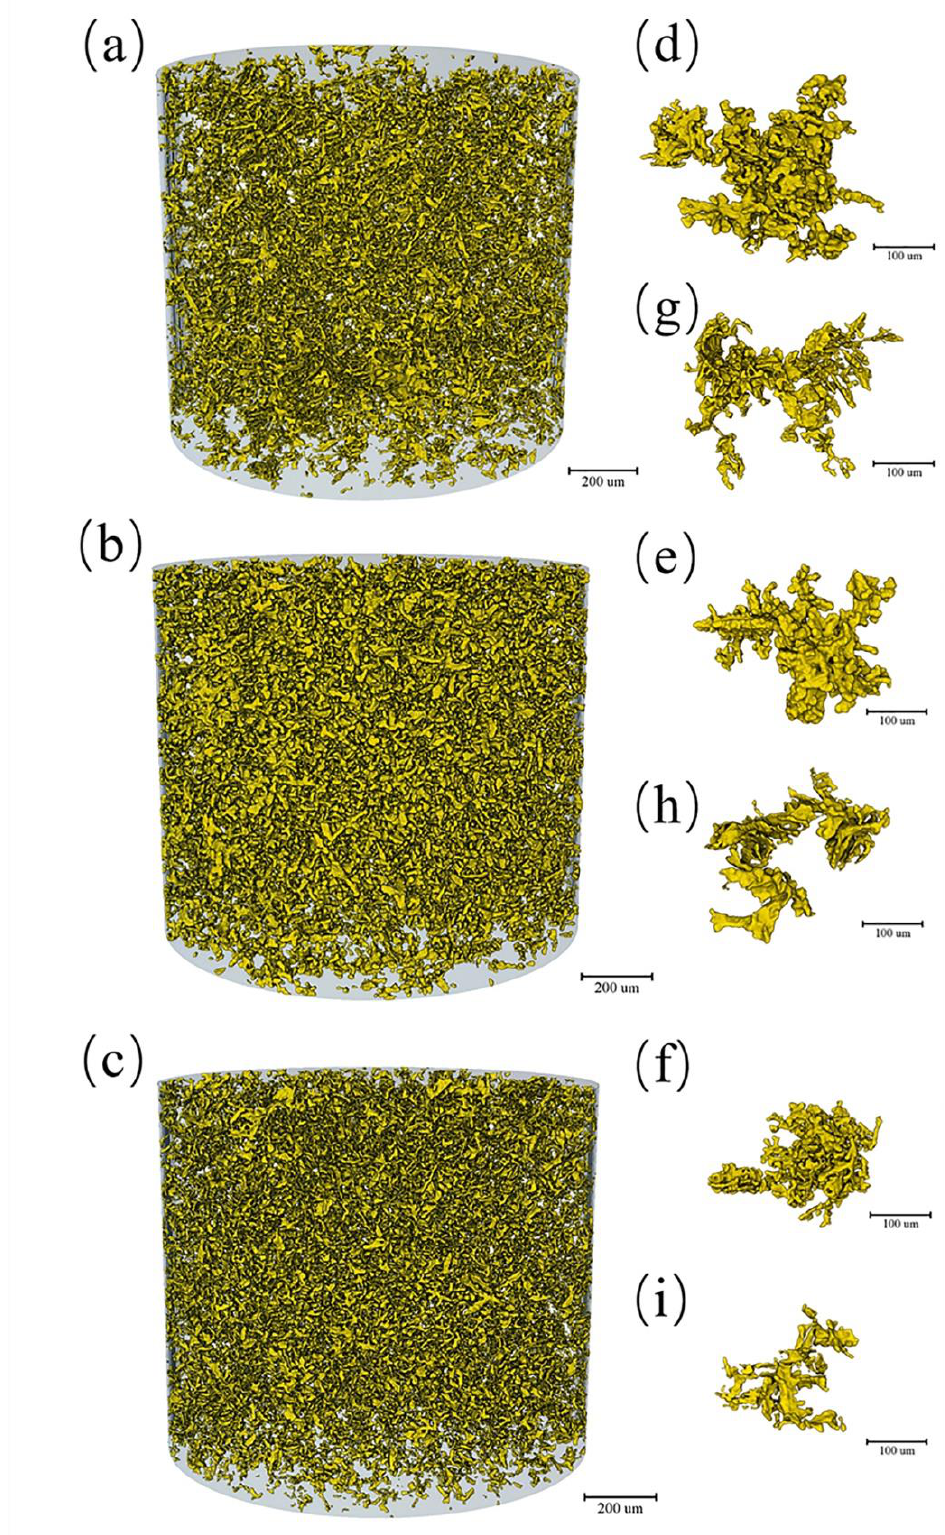
Figure 9. Three-dimensional morphology and distribution characteristics of intermetallic compounds: ( a ) Base; ( b )AlTiB; ( c )AlTiB + 0.1La; ( d – f ) and ( g – i ) The largest size intermetallic compounds and typical lamellar structure corresponding to the 3 groups of alloys, respectively.